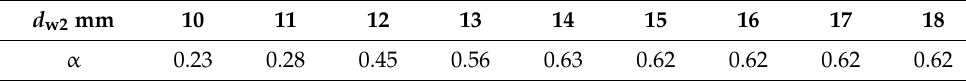
Table 5. Comparison of α under different d w2.